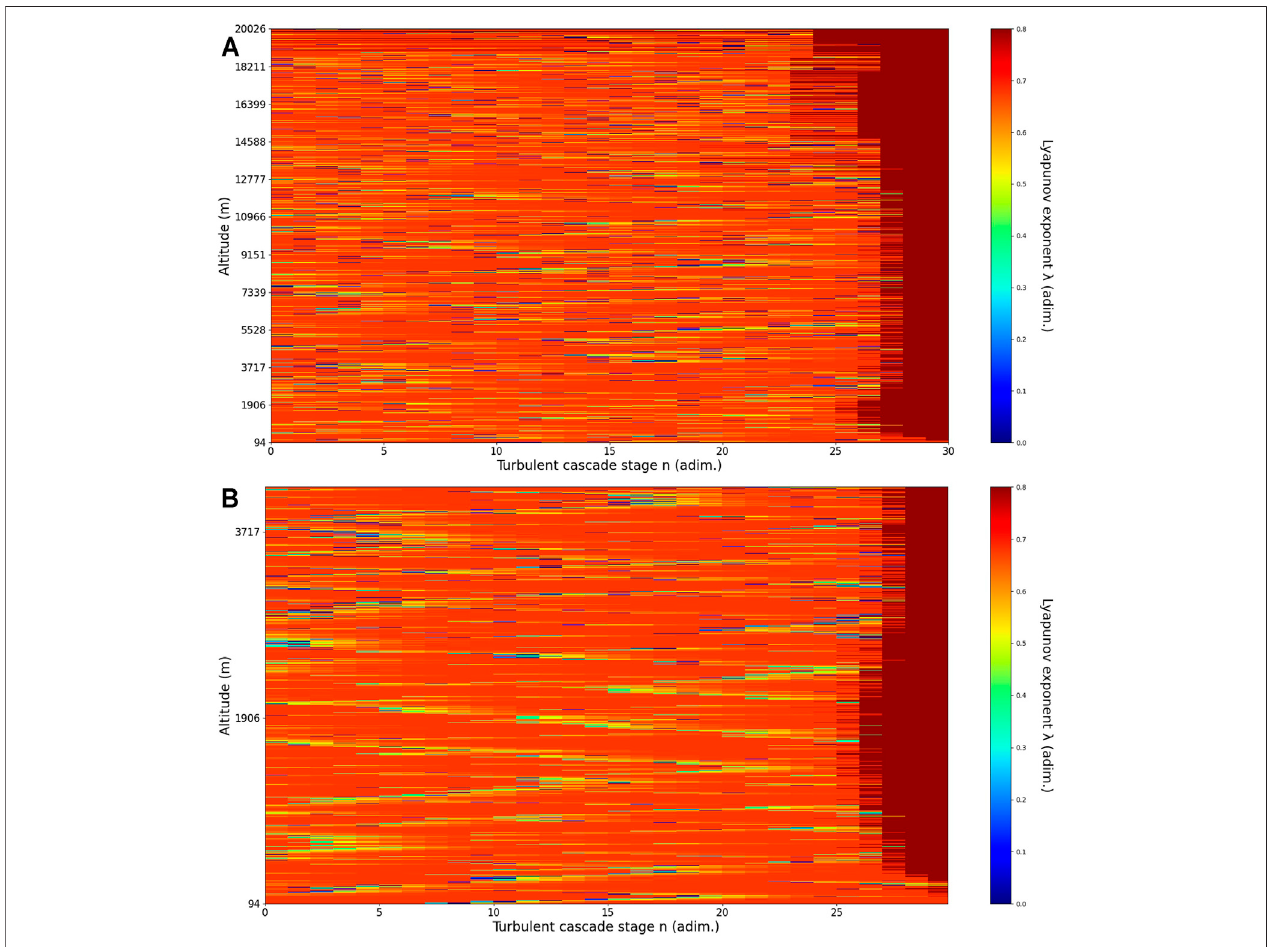
FIGURE 12 | (A) Lyapunov exponent per turbulent cascade stage colormap altitude plot, Bucharest, Romania, 13/06/2019, 07:00:00, (B) zoomed-in Lyapunov exponent per turbulent cascade stage colormap altitude plot, Bucharest, Romania, 13/06/2019, 07:00:00.